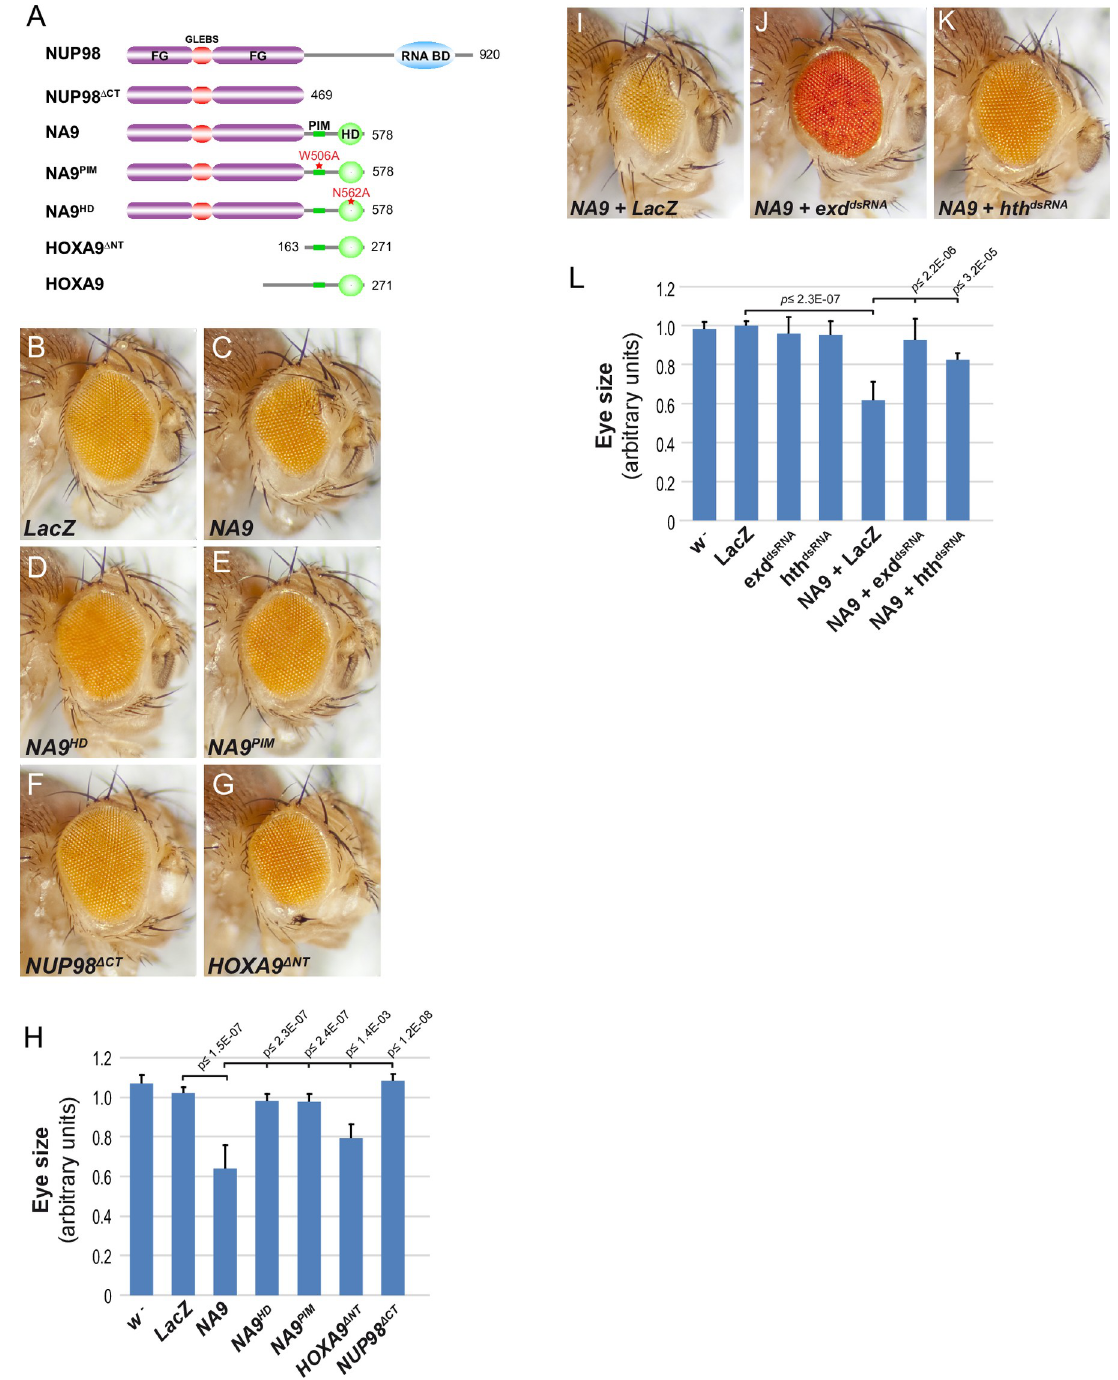
Fig 1. NUP98-HOXA9 expression disrupts Drosophila eye development. (A) Schematic representation of the NUP98-HOXA9 (NA9) variants used in this study. Full-length NUP98 and HOXA9 proteins are shown as reference. The W506A mutation in the PBX-Interaction Motif (PIM) abrogates PBX binding. The N562A mutation in the Homeodomain (HD) prevents DNA-binding. (B-G and I-K) Micrographs of representative adult Drosophila eyes expressing one copy of the indicated transgenes under the UAS promoter driven by ey-Gal4 . The LacZ transgene is used as control. (H and L) Eye size quantification of the indicated genotypes. Statistical significance was assessed using a Student’s t test. Posterior is to the left and dorsal is up. The same orientation is used for all adult eyes and eye imaginal discs shown throughout this